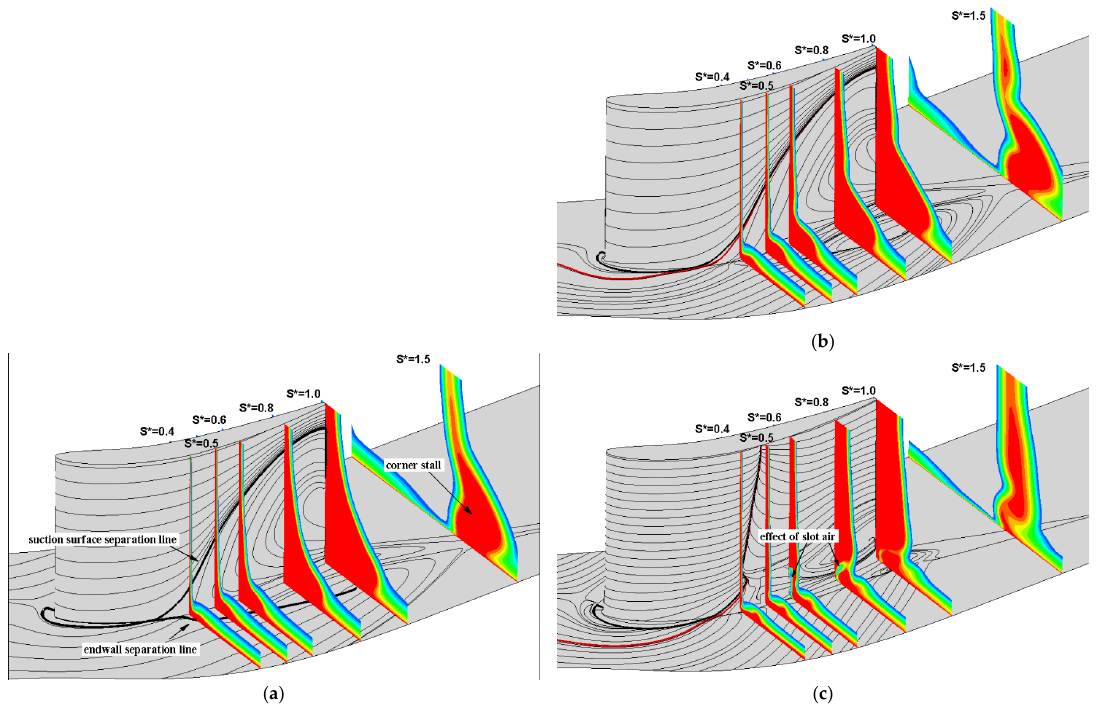
Figure 12. Influence of fillet radius for different incidence angles on the total pressure loss coefficient without the slot configuration.